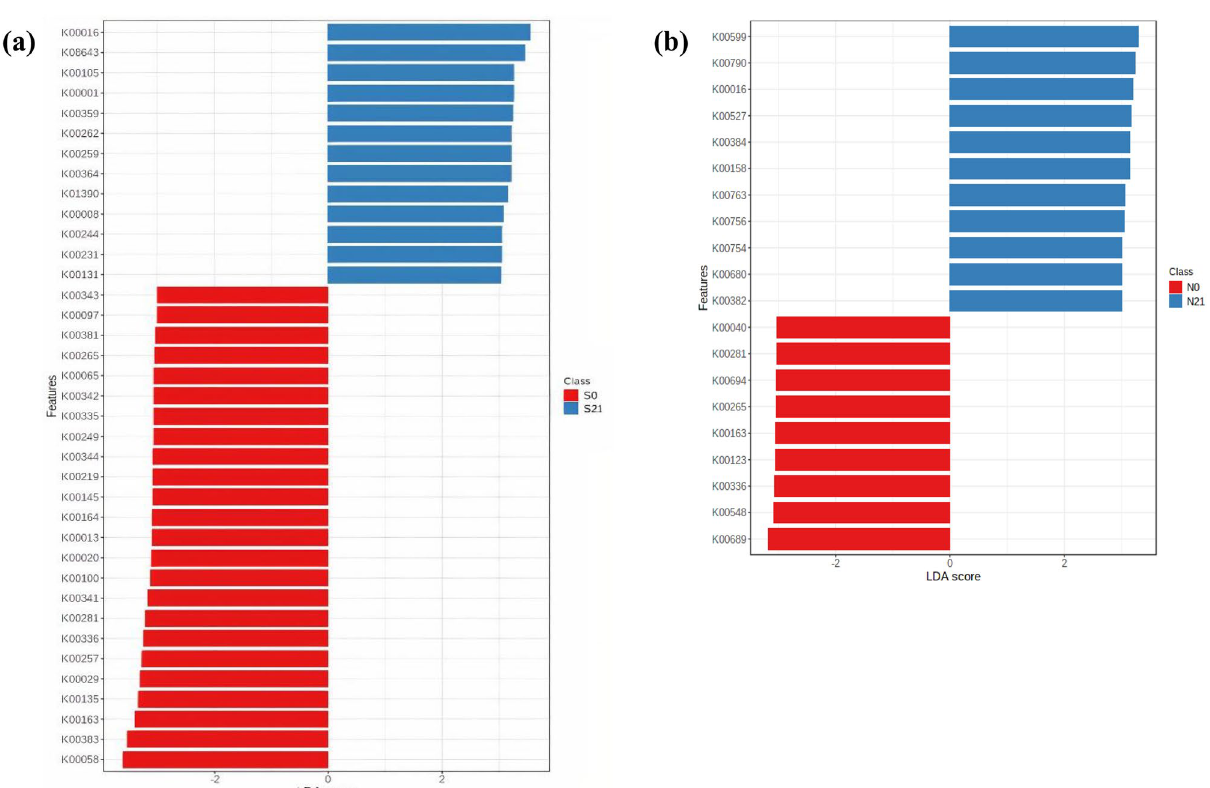
Figure 10. Graphics of linear discriminant analysis (LDA) effect size (LEfSe) of the functional prediction profiles using Tax4Fun between fresh forage and silage. The threshold on the logarithmic LDA score for discriminative features was set to 3.0 at FDR-adjusted p -value < 0.05 (S0, Fresh sweet corn; S21, Sweet corn silage; N0, Fresh Napier; N21, Napier